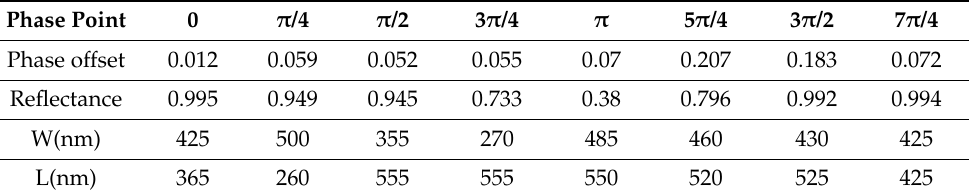
Table 1. Unit-cells selected for designing meta-deflectors. The 0-2 π phase range is discretized into eight segments with an interval of π /4.